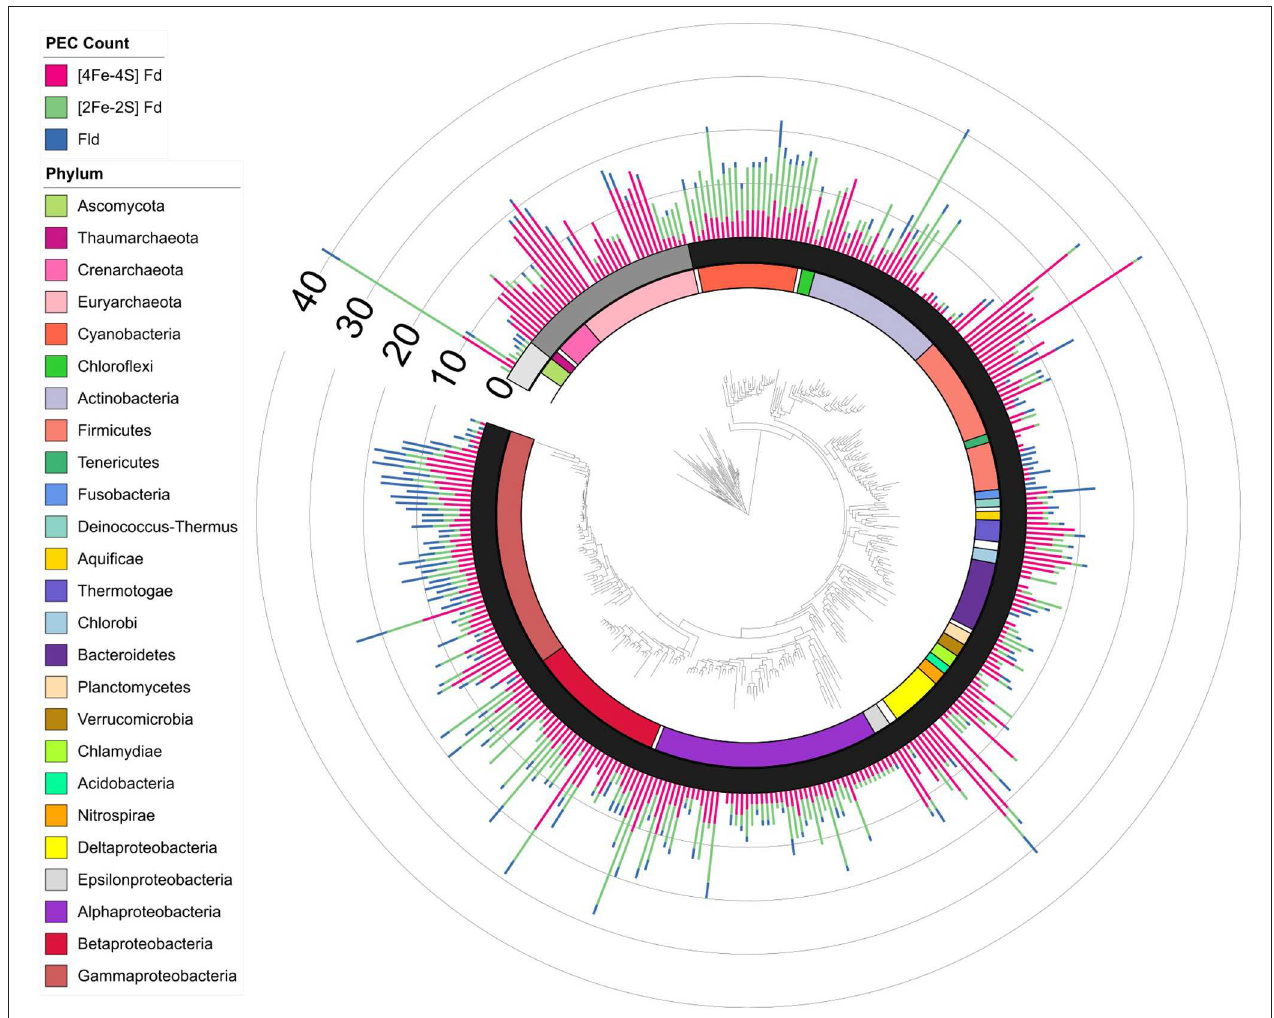
FIGURE 5 | PEC gene abundance mapped onto an evolutionary tree. Bars are used to illustrate the total PEC gene counts of the three different PEC families at the leaves in a stacked bar graph, including [4Fe-4S] Fds (red), [2Fe-2S] Fds (green), and Flds (blue). The domain for each organism is depicted by shading internal to the stacked bars: Eukaryotes (Light gray), Archaea (dark gray), and Bacteria (black). The major phyla and classes of organisms represented in the tree are visualized internal to the domains using the colored bars as noted in the key. Phyla with only one representative are labeled with white